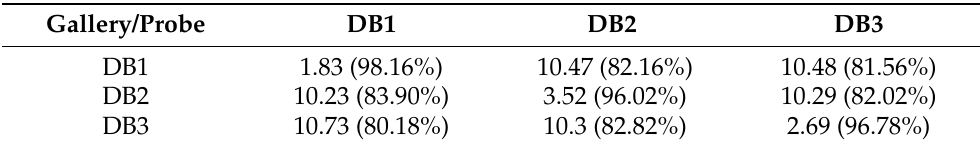
Table 3. The results of SiameseFinger on MOLF database in terms of EER.